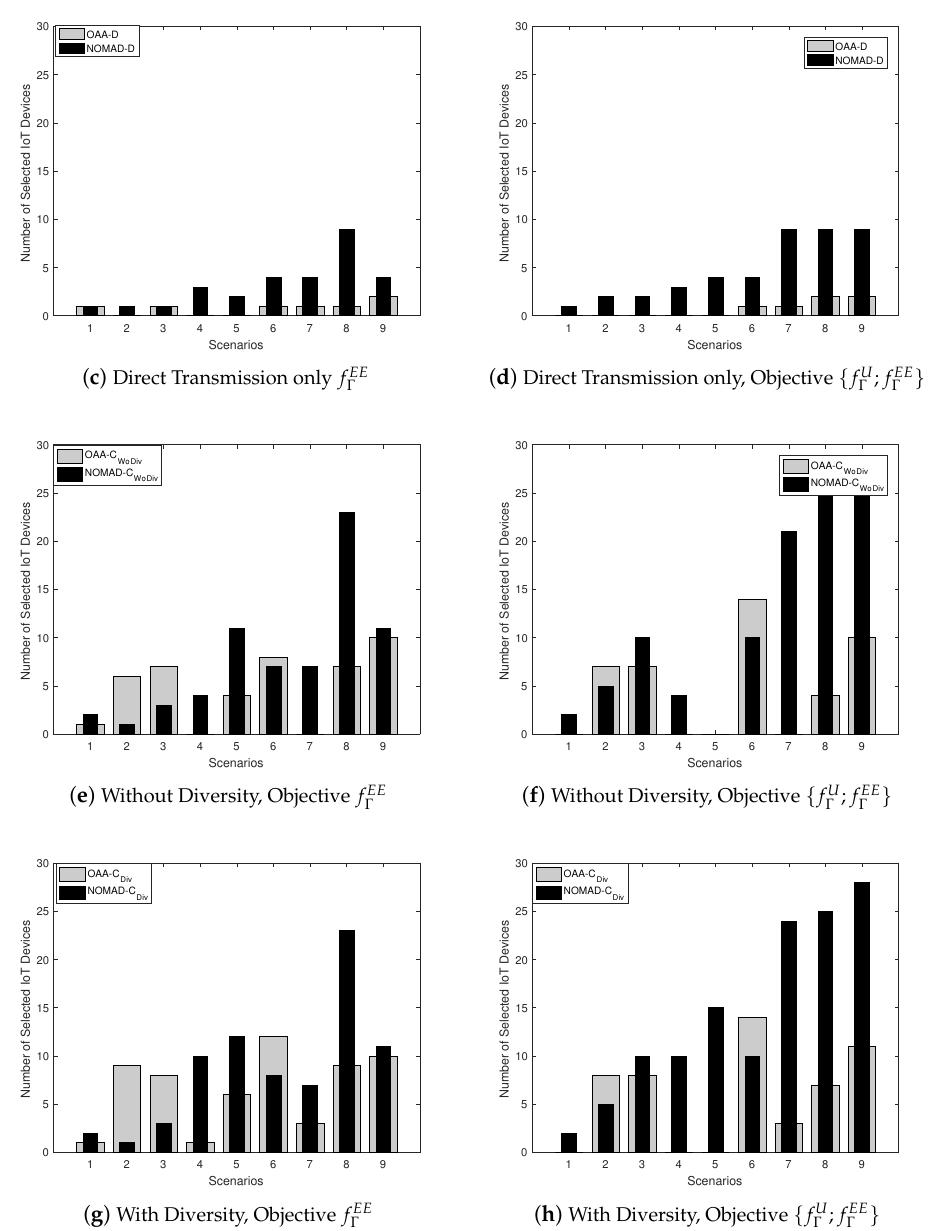
Figure 6. Number of Selected IoT Devices/Mobile Users for various parameters. Required rate 1 Mbps, P max = 20 dbm. Scenarios are { K , R }: {1,2,3,4,5,6,7,8,9} = {(10,5),(10,10),(10,15),(20,5),